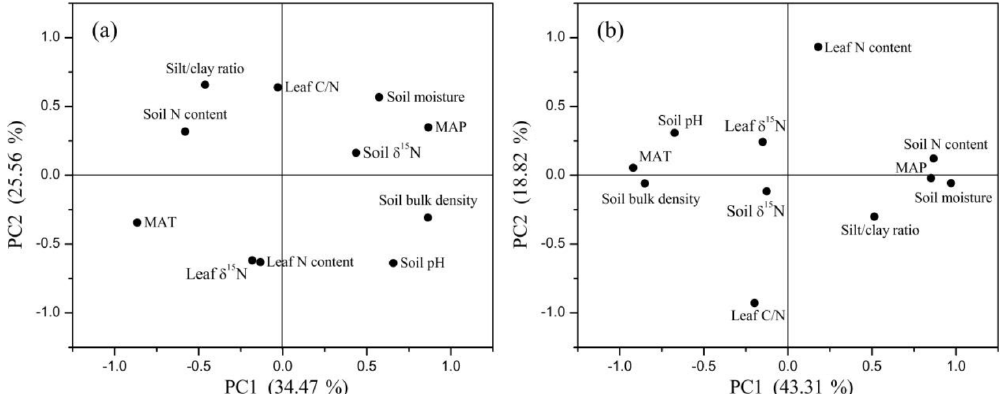
Figure 4. Variable loading on the first two principle components of the north (a) and south slopes (b) of Tian Shan.